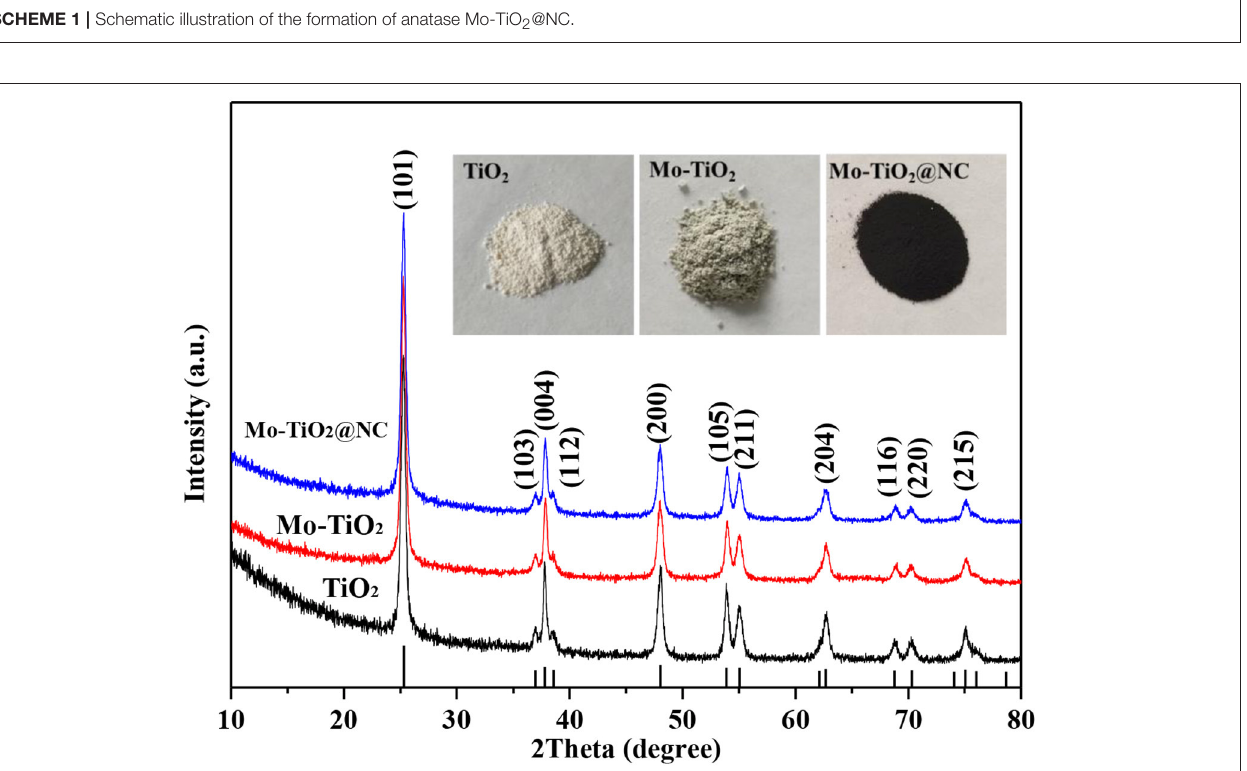
FIGURE 1 | XRD patterns of TiO 2 , Mo-TiO 2 and Mo-TiO 2 @NC. The lower vertical lines represent the JCPDS card no. 01-84-1285 (anatase). The upper inset maps are the physical photos of TiO 2 , Mo-TiO 2 , and Mo-TiO 2 @NC.